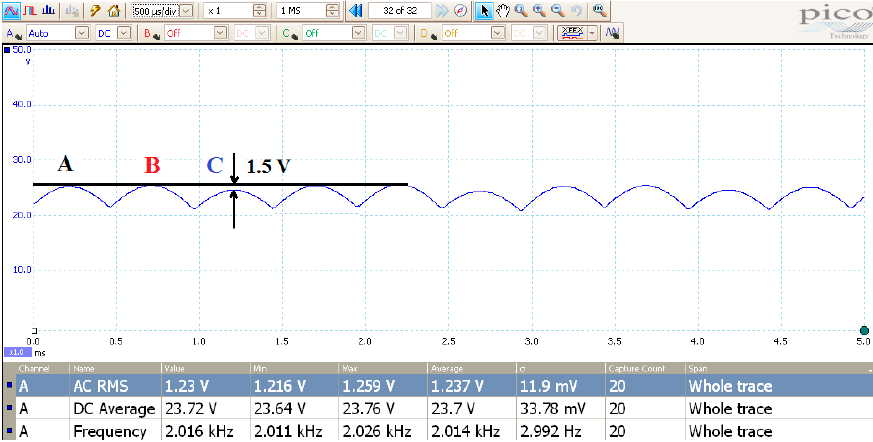
Figure 23. Rectifier output voltage at zero firing angle at m N = 5000 RPM.